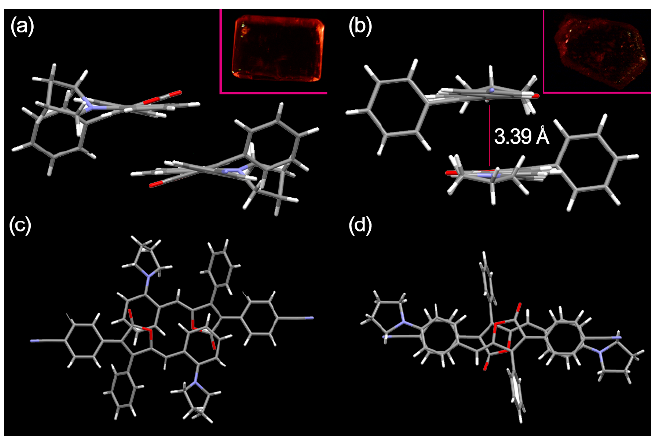
Figure 3. ( a ) Side view of PDB2; ( b ) Side view of PDB4; ( c ) Top view and illustration of no π – π stacking in PDB2; ( d ) Top view and illustration of the π – π stacking in PDB4. Inset: Photos of both the crystal PDB2 and PDB4 under natural light.